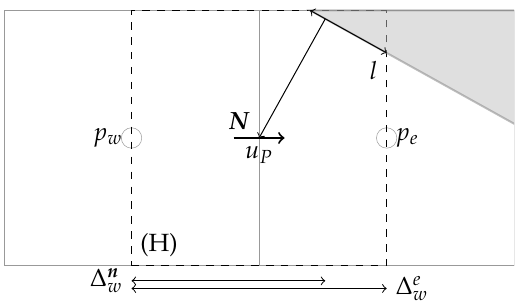
Figure 9. Computation for force requires normal vector from surface N which intersects with u P and area l of solid